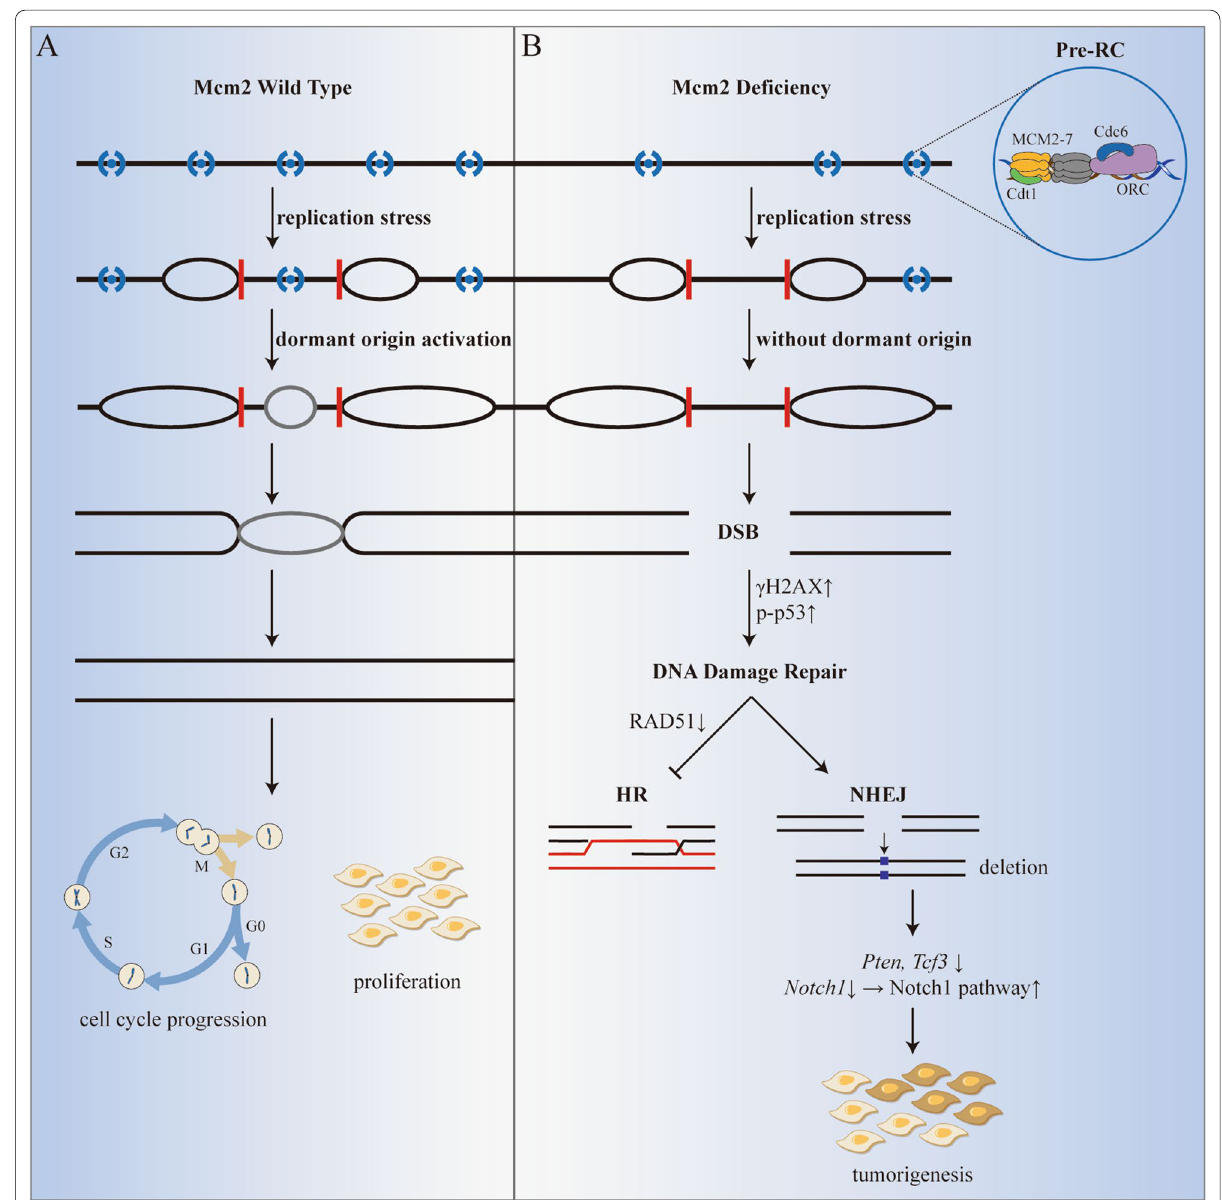
Fig. 2 MCM2 Deficiency and Tumorigenesis. Under replication stress, ( A ) the excess number of dormant origins maintains genomic stability and promotes cell cycle progression in Mcm2 wild-type mice, ( B ) the deficiency of Mcm2 leads to the reduction of dormant origins, the increase of DSBs, and the onset of